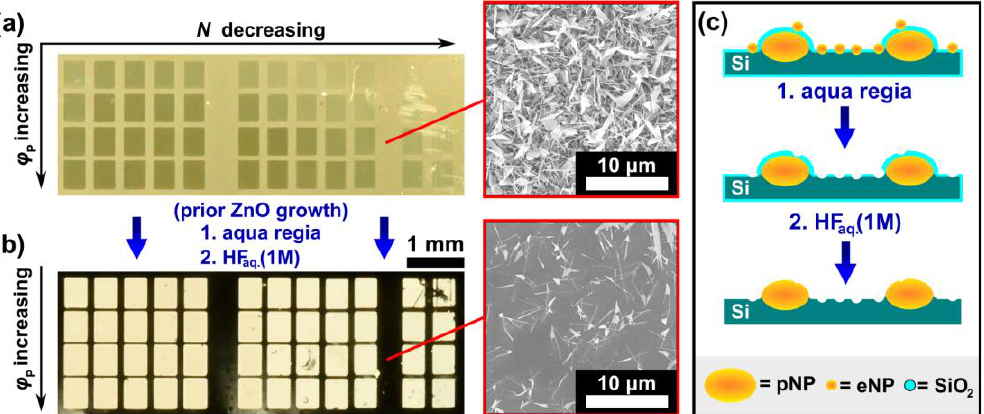
Figure 10. ( a , b ) Photography of an irradiated, initially gold-coated silicon wafer, overgrown with ZnO nanostructures. The wafer in ( a ) remained untreated after laser irradiation, whereas the wafer in ( b ) was consecutively treated with aqua regia and hydrofluoric acid before the ZnO growth. The visibly modified regions were irradiated with decreasing N (2984 to 15) from left to right and increasing pulse fluence 𝜑 𝑝 (112 to 160 mJ/cm 2 ) from top to bottom ( t = 10 min, T = 800 °C). ( c ) Schematic representation of the etching process including aqua regia and hydrofluoric acid, illustrating its effects on the gold nanoparticles and the silicon dioxide layer.